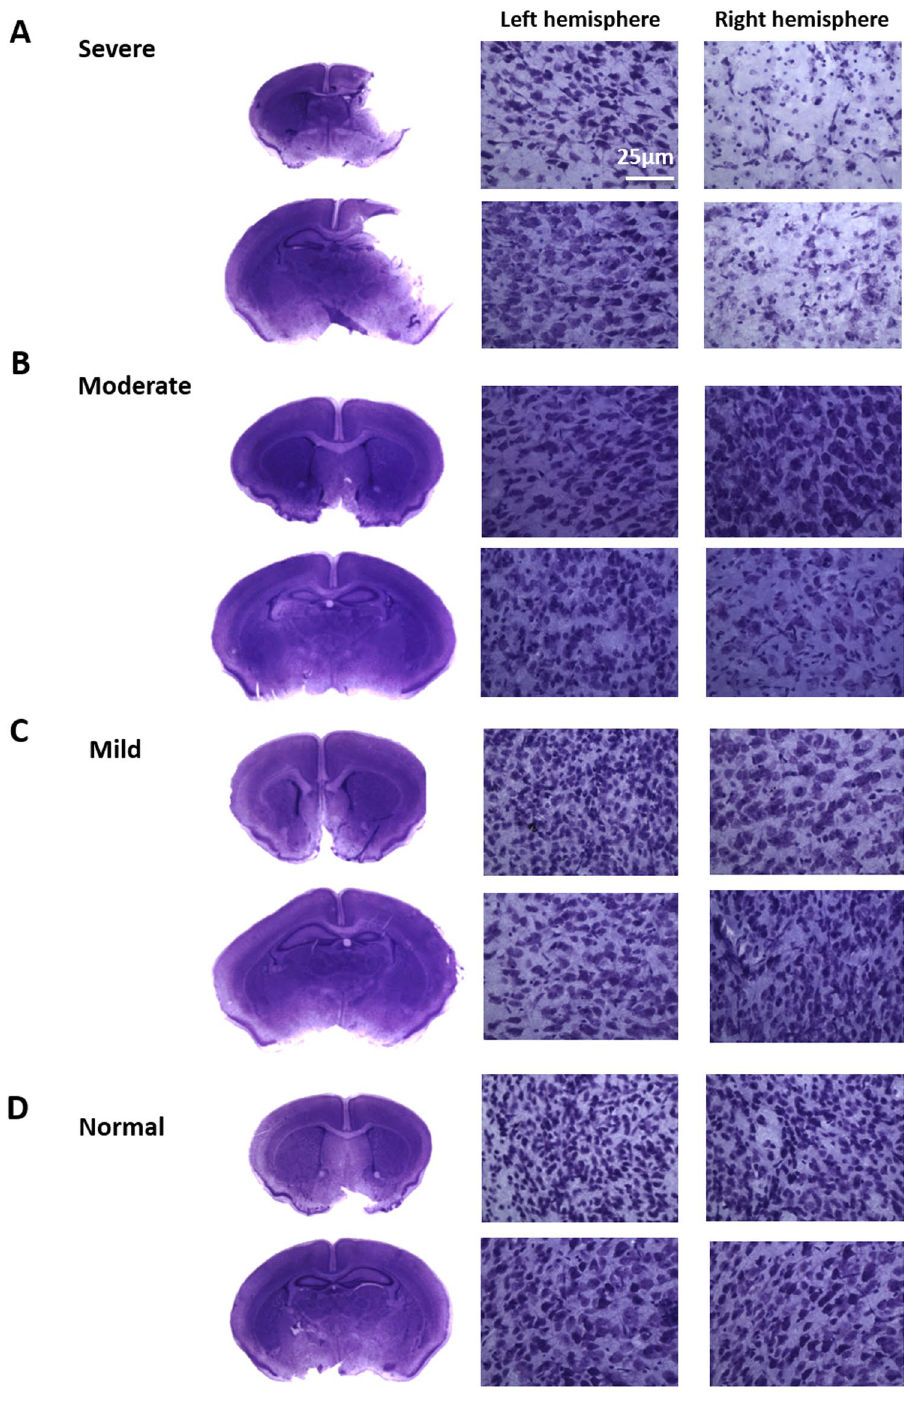
Figure 7. Nissl stain on HIE brains harvested 48 hours after surgery. Nissl stain represents rough endoplasmic reticulum, ribosomal RNA and DNA. Nissl bodies are seen within Neuronal cell bodies, however disappear in response to ischemia due to neuronal cell death. ( A ) Brains showed neuronal cell death within the cortex and hippocampus of the lesioned right hemisphere. Nissl bodies were somewhat absent within the ( B ) moderate and ( C ) mild right hemispheres. Whereas Nissl bodies were present within the ( D ) normal brain. The brain section images were taken at × 5 magnification and the left and right hemisphere images were taken at × 40